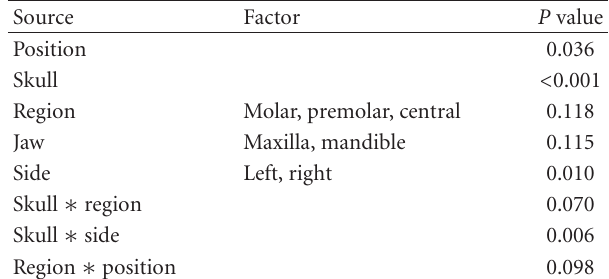
Table 4: Assessment of di ff erence between radiographic and physical measurements: univariate ANOVA and resulting P values.